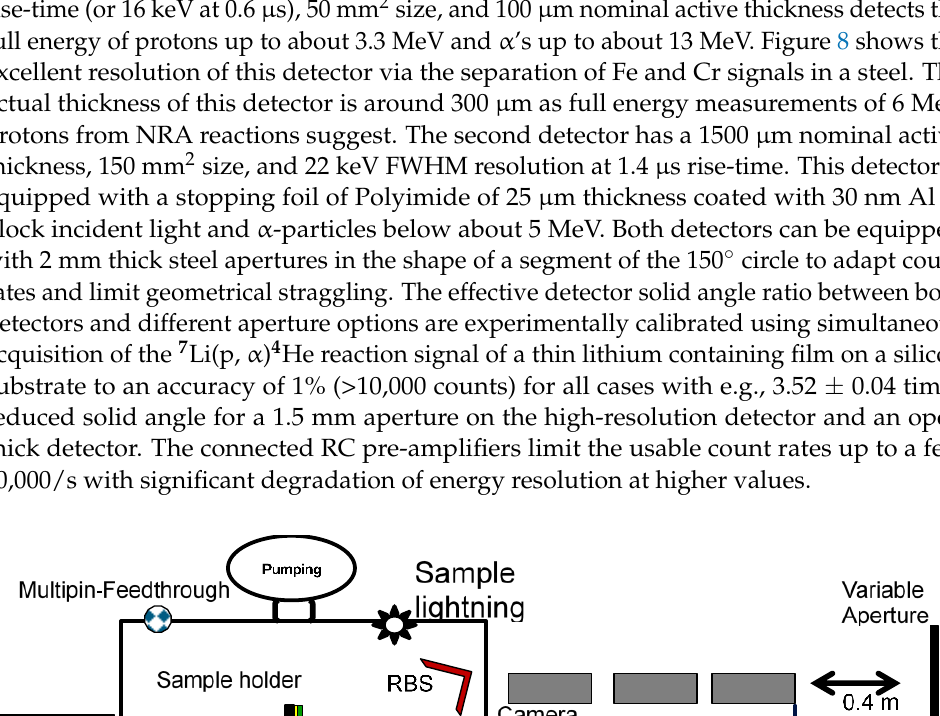
The detector normal points at the sample surface with an angle of 62.5° from a port in the upper plane. Its distance to the sample can be adjusted from 30 to 200 mm to optimize count rates. The detector is calibrated by K and L lines from high purity W, Mo and Y targets. Its H factor (energy dependent sensitivity) is determined by the same samples in combination with normalization by the respective RBS signals. A HPGe detector with 76.2 mm crystal diameter is installed at the backside flange of the chamber as seen by the ion beam for particle induced gamma-ray analysis (PIGE). In this geometry, the photons will be detected only after passing the sample and the sample holder, but for the relevant photon energies and the holder construction, only a minor absorption can be expected. For the efficiency calibration, known lithium, aluminum, and boron samples are exposed together with RBS and NRA measurements for cross-calibra- tion. The system achieves an overall detection efficiency in the order of 1% (478 keV pho- tons).